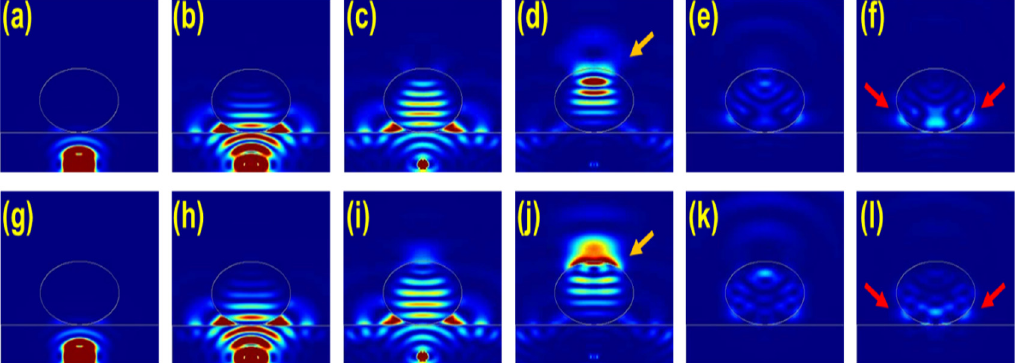
Figure 7. Evolution of travelling light via An-TiO 2 NSs ( a – f ) and Am-TiO 2 NSs ( g – l ) with respect to change of time. The red arrows represent the backscattering from the interface of air/TiO 2 sphere to p-GaN.